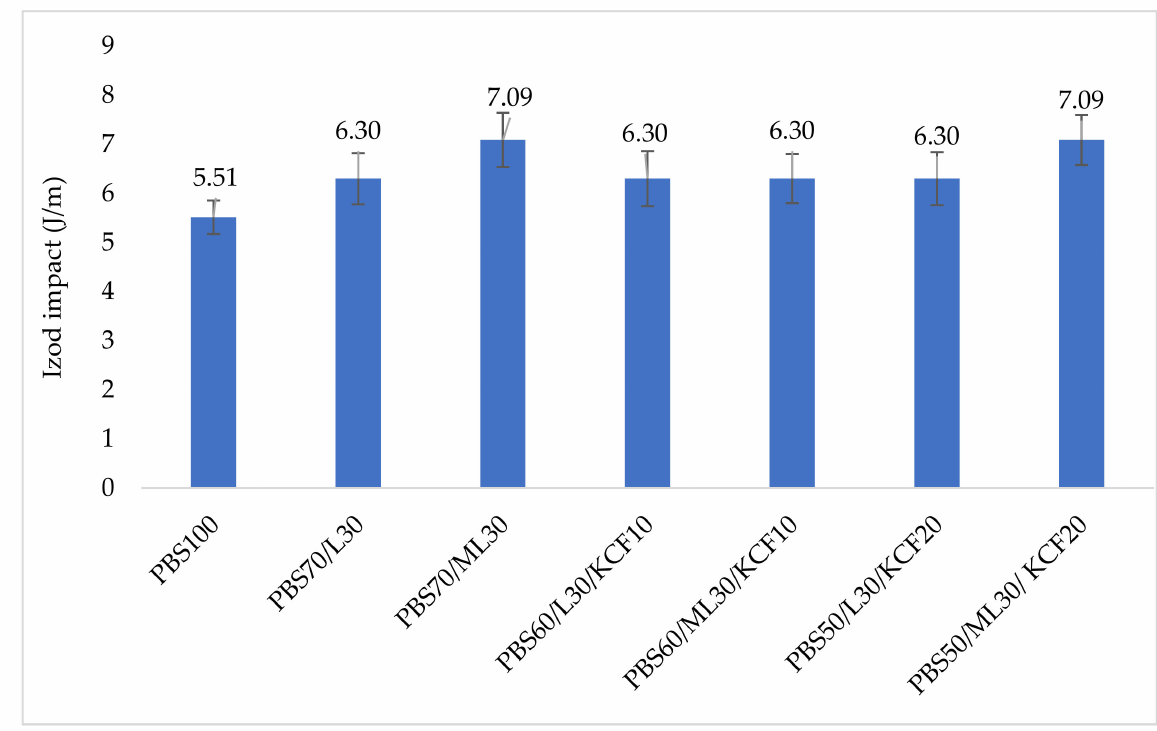
Figure 9. Impact test for PBS and its composites. Note: Poly (butylene succinate) (PBS), Lignin (L), Modified Lignin (ML), Kenaf Core Fiber